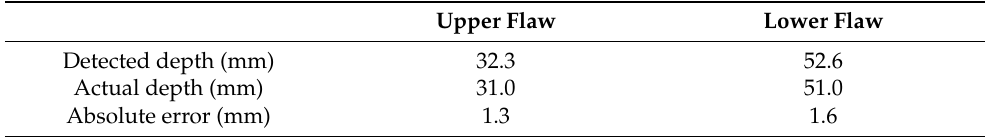
Figure 9. ( a ) A noisy signal measured from the experiment. ( b ) The signal to be analyzed containing two flaw echoes, NSNR = 0.2864. ( c ) The signal de-noised by our method, NSNR = 0.9596. ( d ) The signal de-noised by DWT (4-level sym25), NSNR = 0.2685. Table 1. Flaw detection results using the proposed method.